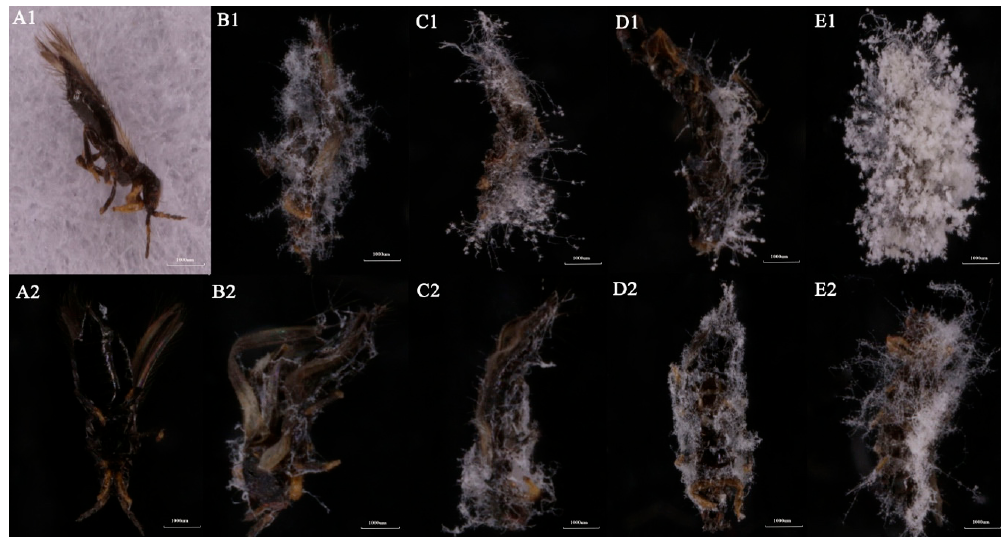
Figure 4. Images of M. usitatus infected with strains SCAUDCL-38 and SCAUDCL-56, observed through a dissecting microscope. ( A1 , B1 , C1 , D1 , E1 ) are SCAUDCL-38-infected M. usitatus at 24 h, 48 h, 72h, 96 h, and 120 h post-inoculation; ( A2 , B2 , C2 , D2 , E2 ) are SCAUDCL-56-infected M. usitatus at 24 h, 48 h, 72 h, 96 h, and 120 eh post-inoculation. Scanning electron microscope images clearly showed the development of fungal hyphae throughout the body of M. usitatus (Figure 5). The results indicated that the adults were infected and killed by A. attenuatus .